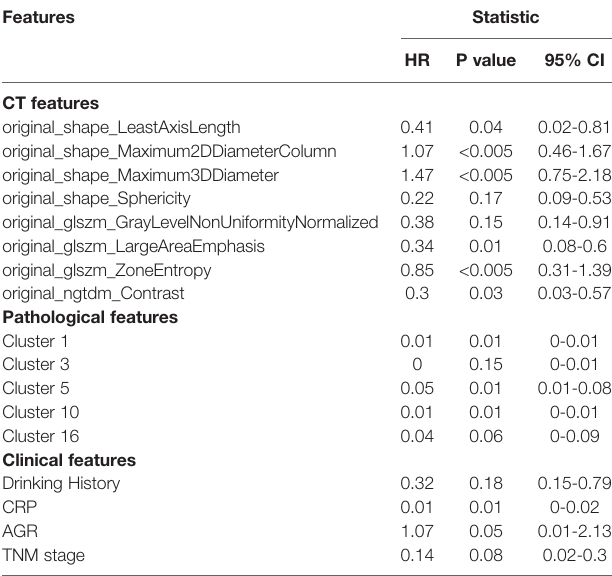
TABLE 3 | Selected features from medical images and clinical information by RFE.